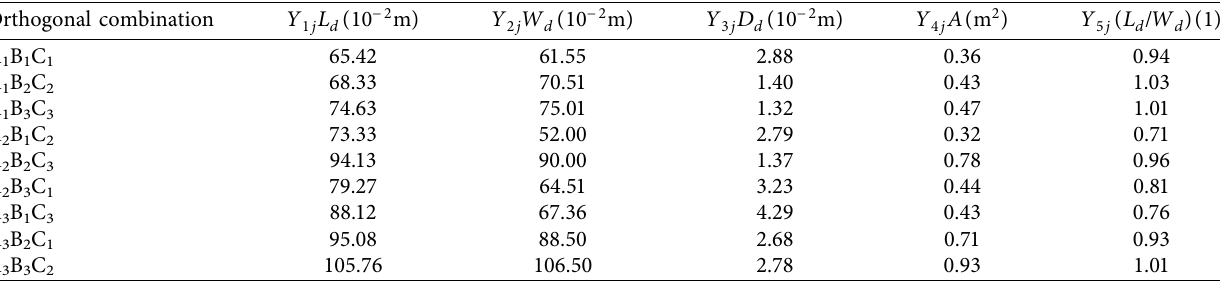
Figure 4: Schematic illustration of devices: (a) The flowslide deposit characteristics; L d Maximum sliding length of flowslide deposit on the surface; W d Maximum width of flowslide deposit; D d Maximum depth of flowslide deposit; A Area of flowslide deposit projected on horizontal plane; θ slope angle; H Height of sandbox measuring from center of gravity; L Total sliding distance of flowslide deposit. (b) The process of center gravity constantly. Table 2: Statistics on flowslide deposit morphology.